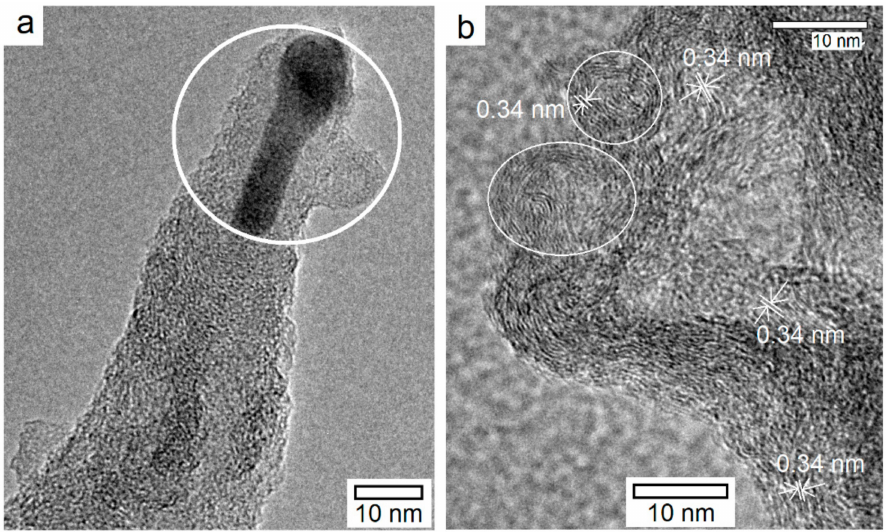
Figure 7. High-resolution TEM microstructures of the carbon nanostructures after PECVD at 900 ◦ C using C 2 H 2 :NH 3 mixture of 1:5.3 (sccm): ( a ) The near-tip area of an individual carbon nanofiber, (Sample S 5 ) and ( b ) top view showing few-walled CNT with open ends and carbon nanosheets (Sample S 7